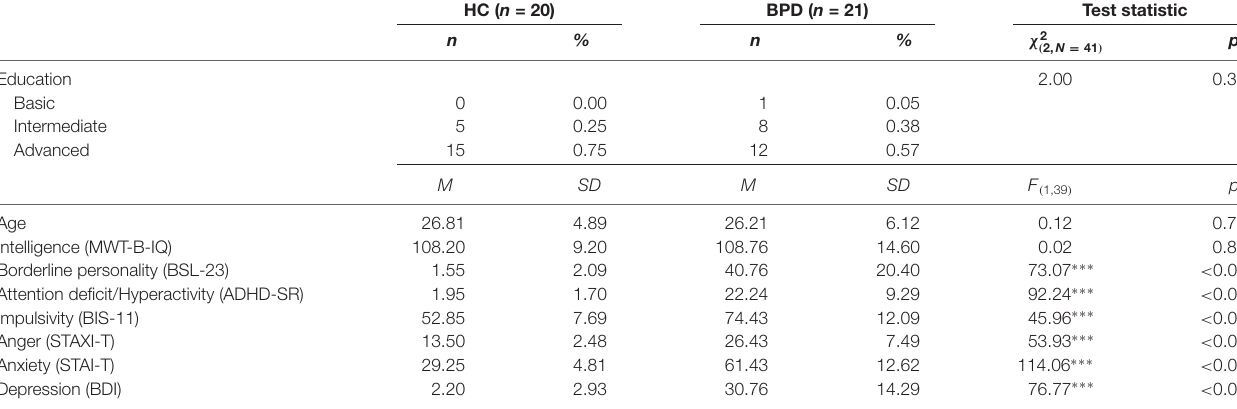
TABLE 1 | Differences in demographical and psychopathological measures between HC and BPD